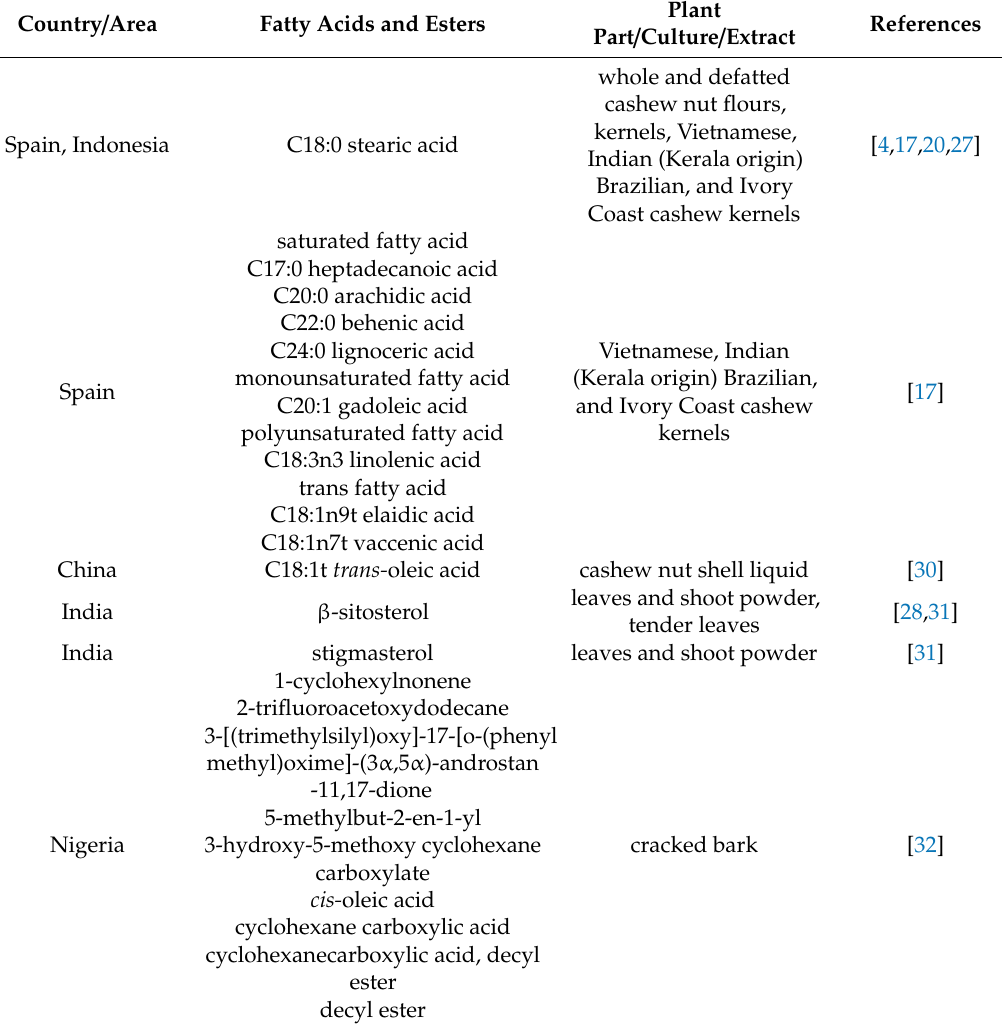
Table 4. Fatty acids and esters present in Anacardium